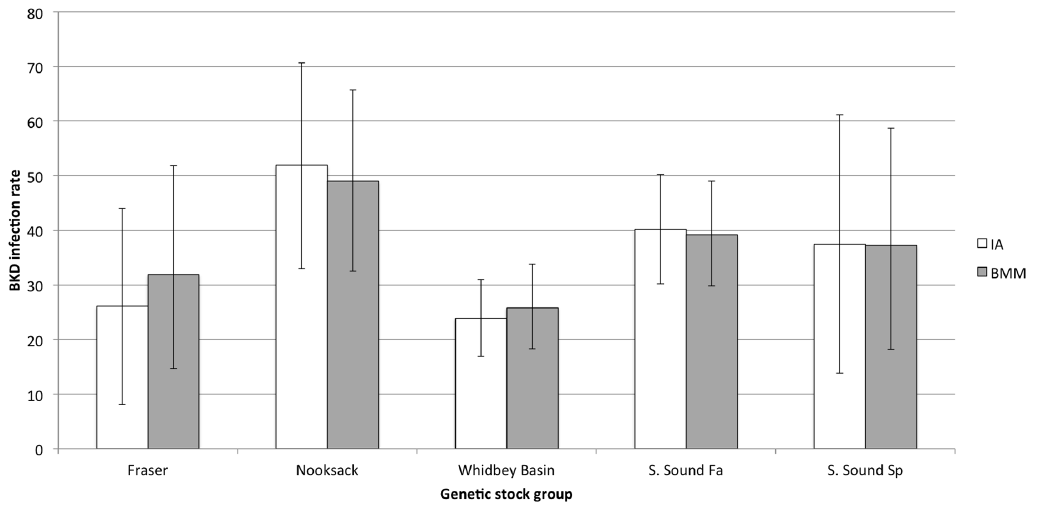
Figure 5. Similar stock-specific estimates of BKD prevalence were obtained using individual assignment (0.8 probability threshold) and Bayesian mixture modeling for reanalysis of Puget Sound Chinook salmon juvenile mixtures. Brackets are shown for confidence and probability intervals (95%).